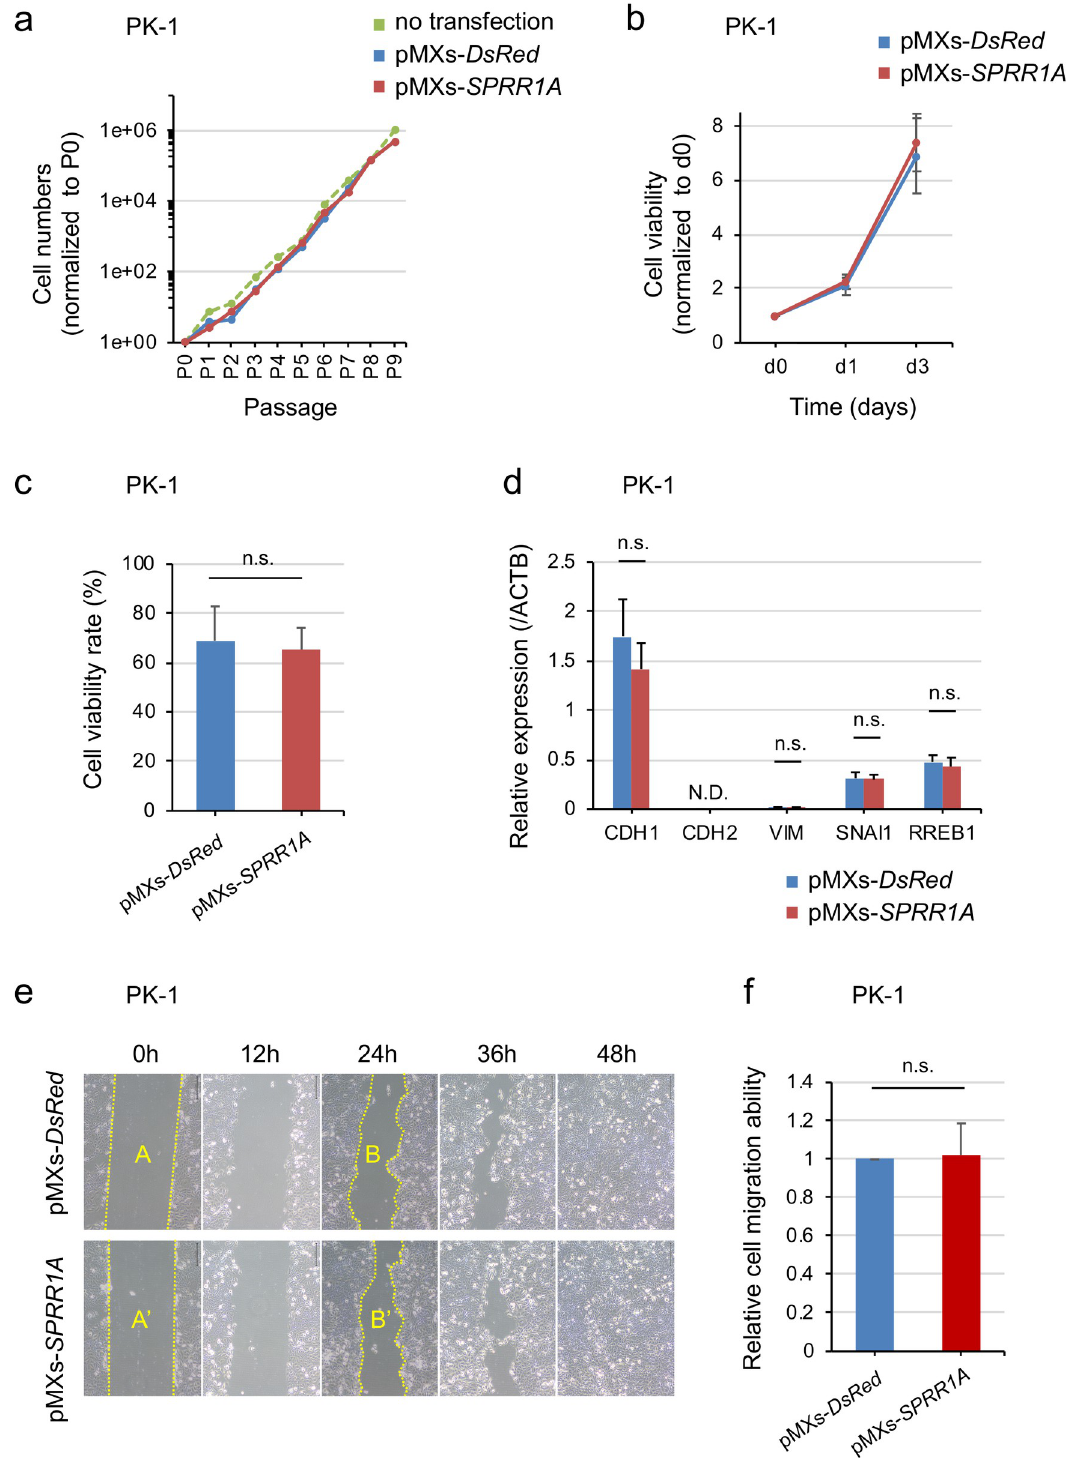
Fig 4. The overexpression of SPRR1A did not influence cell proliferation, chemo-resistance, EMT or the migration ability in pancreatic cancer cells. (a) Cell proliferation. The number of SPRR1A-transduced PK-1 cells was counted every 3–4 days after transduction. (b) Cell proliferation assay. The number of viable cells was assessed at days 0, 1 and 3 by measuring cellular ATP levels. (c) Chemo-resistance to Gem. The cell viability in the presence of Gem was calculated as a percentage of the viability in its